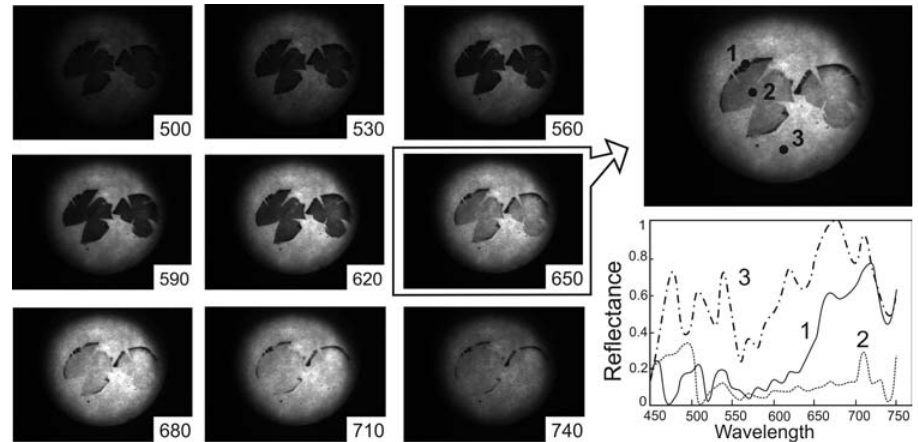
Fig. 5. Spectral images (500 – 740 nm) of mouse testicle and measured re°ectance spectra at three points: 1 — testicle membrane, 1 — testicle body, 3 — ¯xative compound.